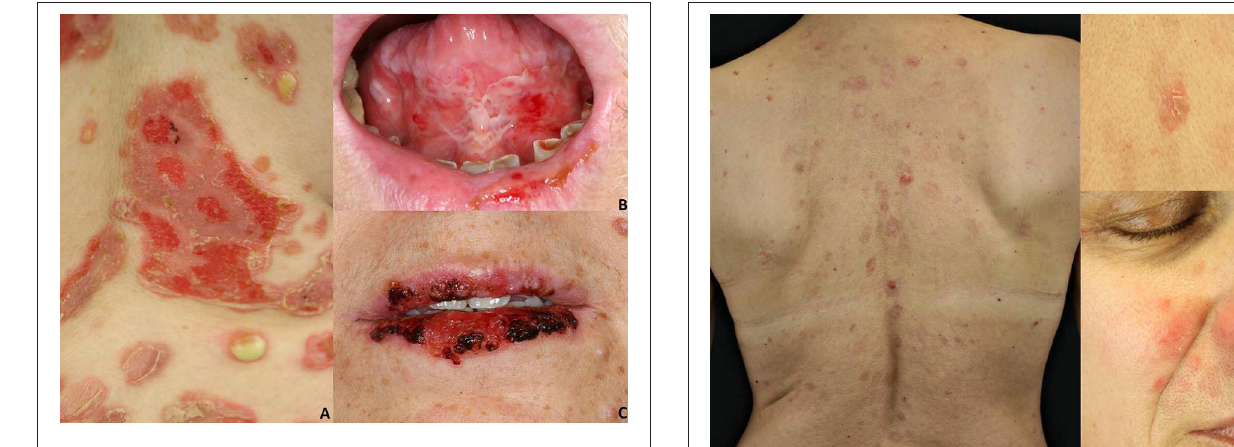
phenomenon represents the clinical hallmark of pemphigus vegetans (PVe) (30), which accounts for < 5% of pemphigus cases (30).